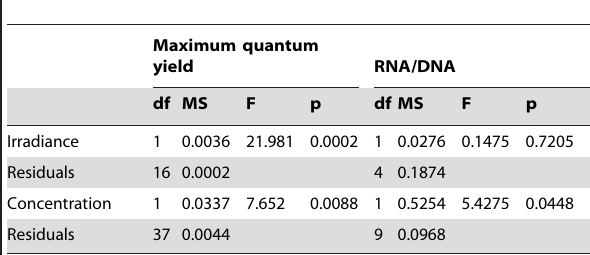
Table 5. Treatment effects on maximum quantum yields and RNA/DNA ratios in corals in the aquarium experiment.